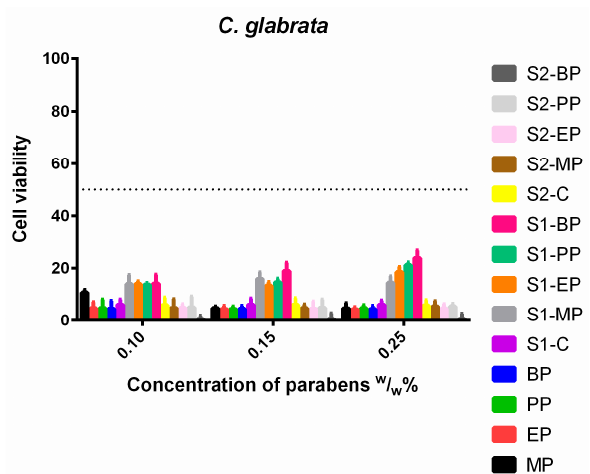
Figure 10. Cell viability of C. glabrata against the control paraben solutions (MP; EP; PP; BP); the first system (S1-MP; S1-EP; S1-PP; S1-BP) and the second system (S2-MP; S2-EP; S2-PP; S2-BP). Cell viability expressed as the percentage of the absorbance of the untreated control. Data expressed as mean ± SEM, n = 4. Cell viability of fungal cells at 0.1; 0.15; 0.25 ( w / w )% concentrations of different formulations containing parabens: MP: 11% ± 1.1%; 5% ± 0.7%; 5% ± 2%; EP: 5% ± 2.3%; 4% ± 1.2%; 4% ±